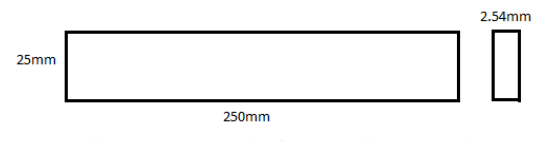
Fig 3: Test Sample for Tensile Strength